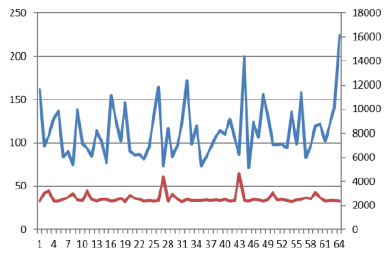
Figure 15: Details ofTexture Mapping Result.